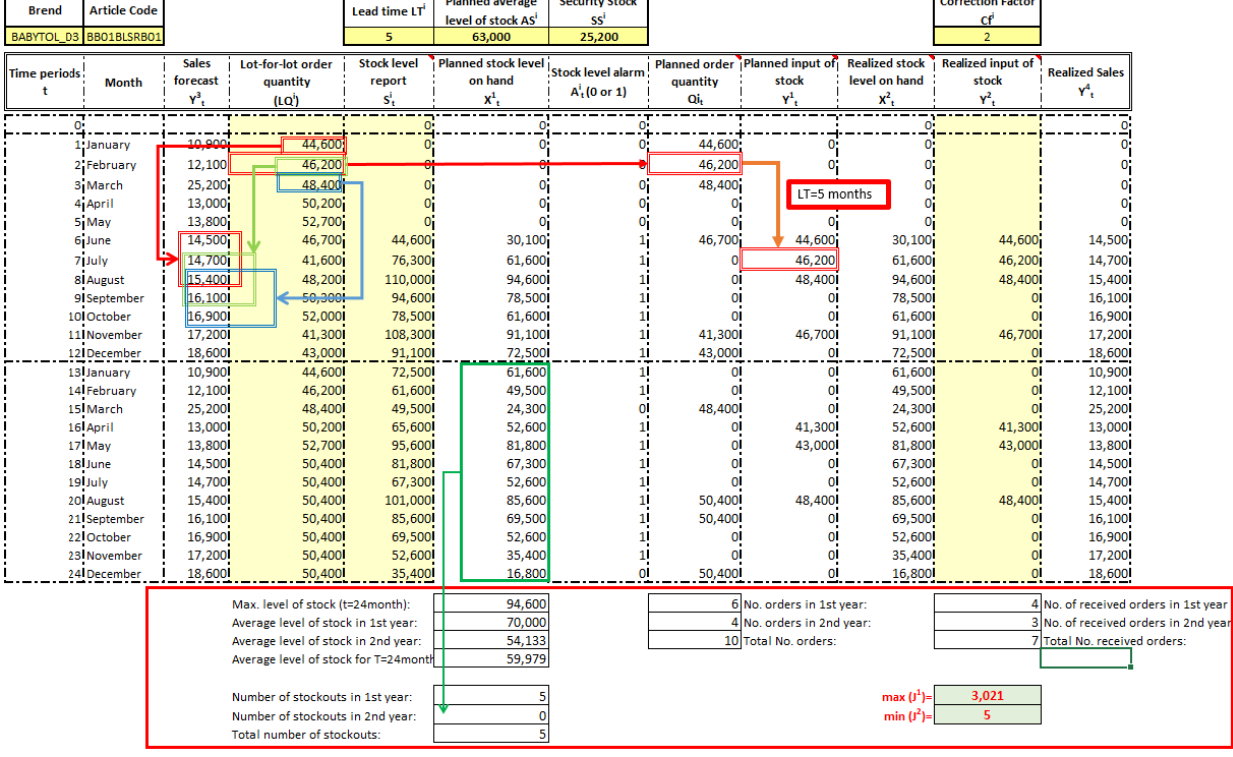
Figure 10. Elements of the spreadsheet model for Case 1: LFL policy with deterministic demand. Table 3. Numerical results of Case 1 and Case 2 for Instance